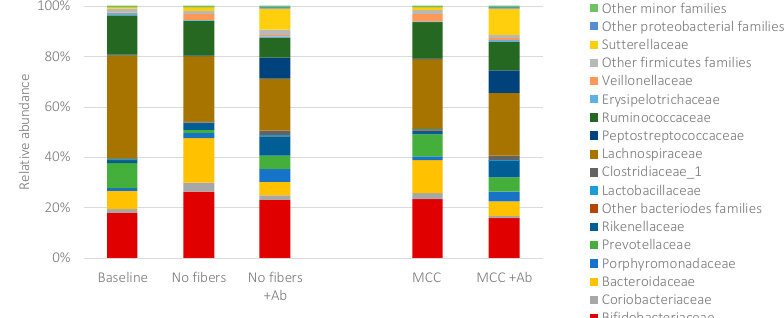
Figure 3. The bacterial community profile at family level in the control samples (baseline, no fibers, microcrystalline cellulose) without and with amoxicillin-clavulanate (Ab) after 48 h of incubation. MCC—microcrystalline cellulose; Ab—amoxicillin-clavulanate.